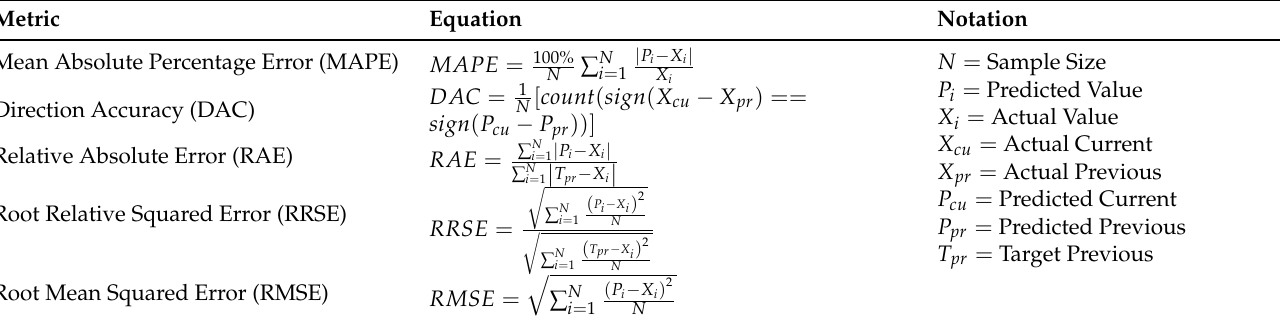
Table 1. Performance evaluation metrics for time series